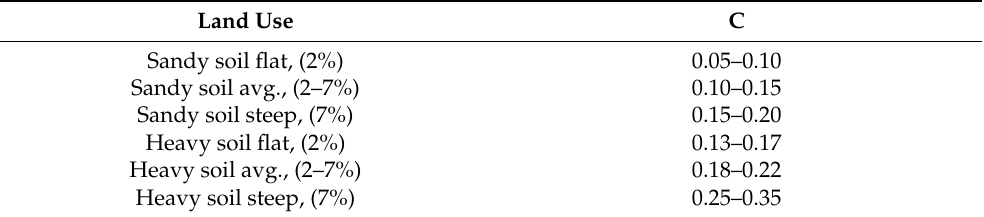
Table 2. Runoff coefficient for lawns [16].